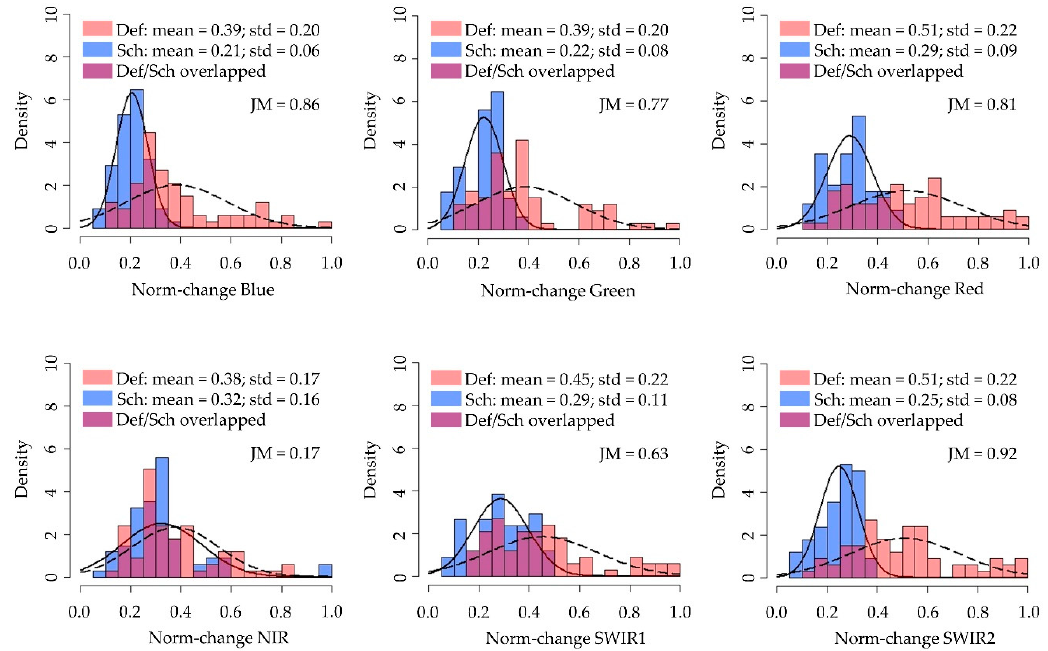
Figure 4. Deforestation (Def) and seasonal change (Sch) distributions overlaid with probability density function (pdf) fitted separately for each Landsat OLI band mean and standard deviation (std) of the derived pdfs and the Jeffries-Matusita (JM) distance are given. JM ranges between 0 (total inseparable) to 2 (total separable).